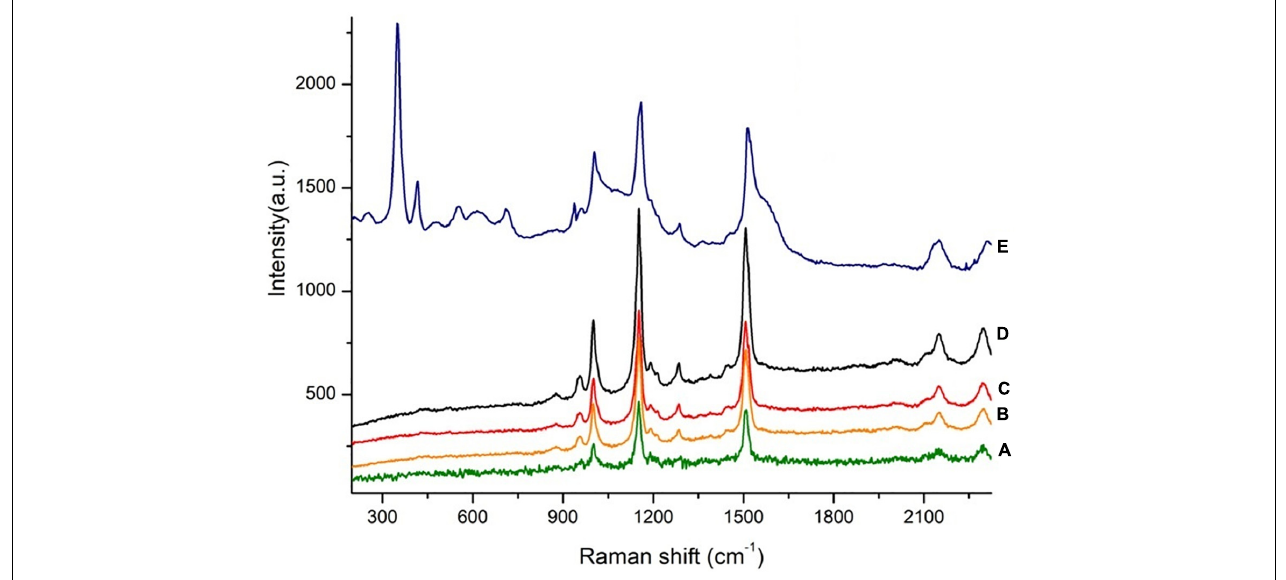
FIGURE 6 | Raman spectra of red colonies deriving from (a) H. salinarum ; (b) salted sheep rawhides [SRH + NaCl POTECO ]; (c) salted bovine rawhides [BRH + NaCl POTECO ]; (d) NaCl POTECO ; and (e) red damaged tanned leathers (DTLs).